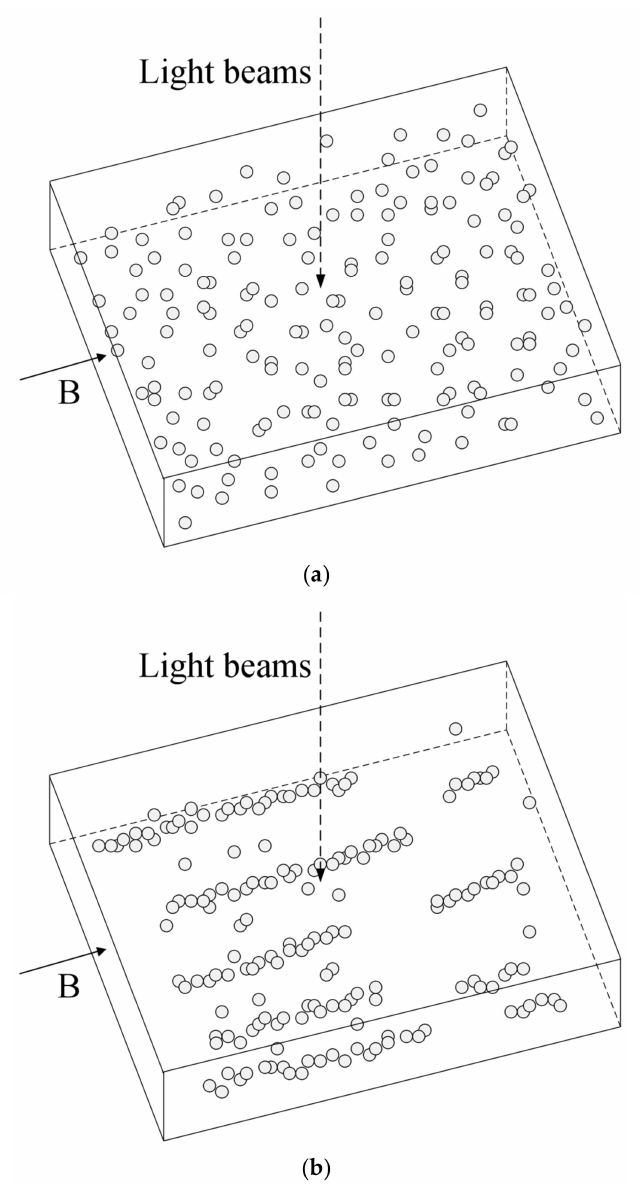
Figure 3. The representative volume elements for ( a ) unstructured and ( b ) structured films. B denotes the applied magnetic